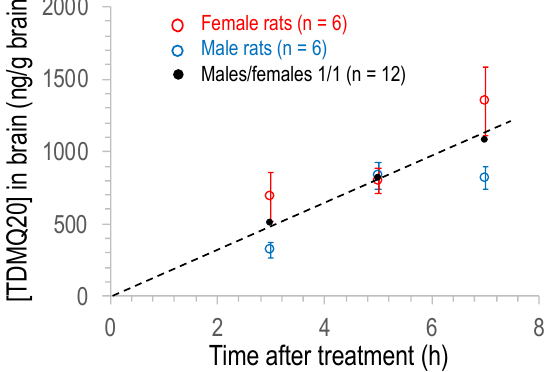
Figure 4. Plot of the concentration of TDMQ20 detected by LC–MS/MS in brain homogenates of male (blue) or female (red) or male/female, 1/1 (black) rats as a function of time after oral administration of the drug (25 mg/kg). Each dot is the mean value of 6 males, 6 females or 12 rats (male/female ratio = 1/1). Vertical bars stand for SEM values.